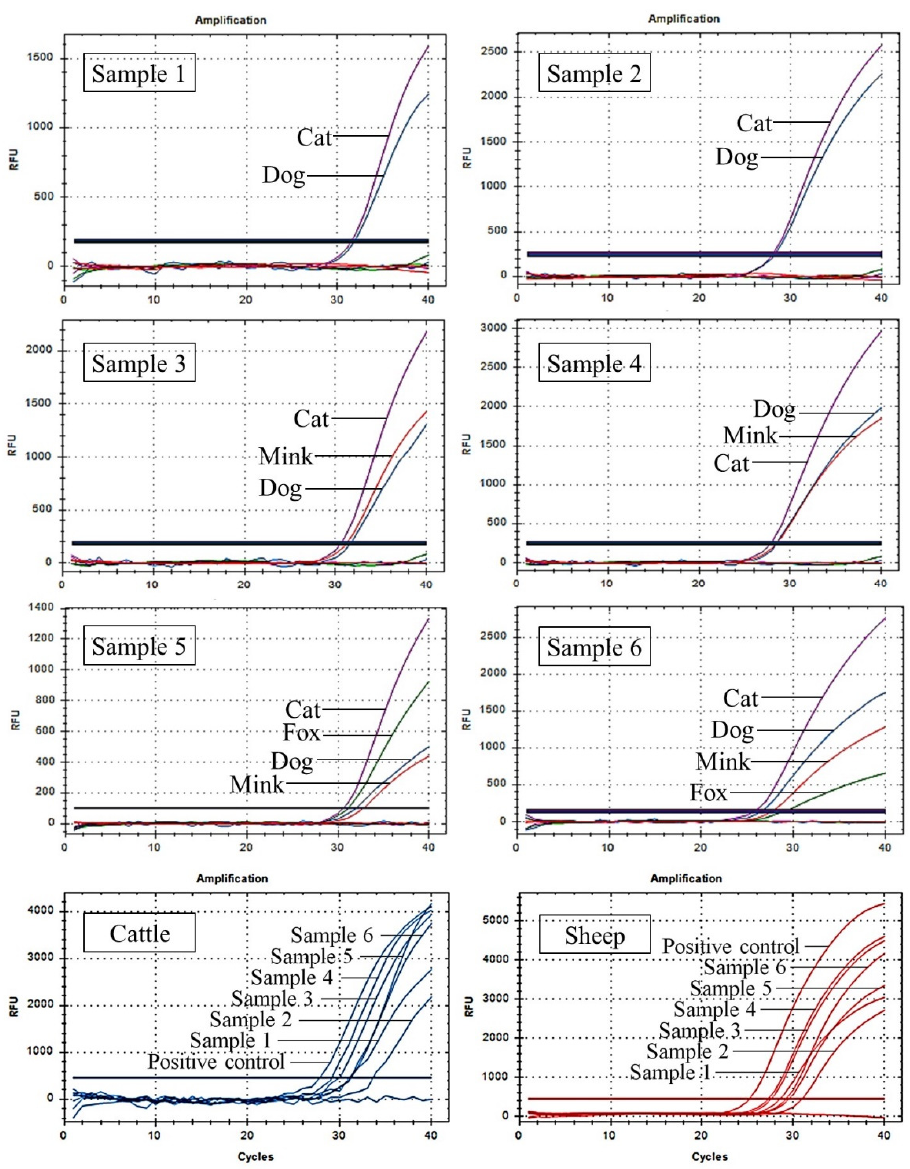
Figure 7. Detection of cat-, dog-, fox-, mink-, cattle-, and sheep-derived ingredients in six artificial meat samples using UP-M-rtPCR. Table 3. Analysis of six artificial meat samples.